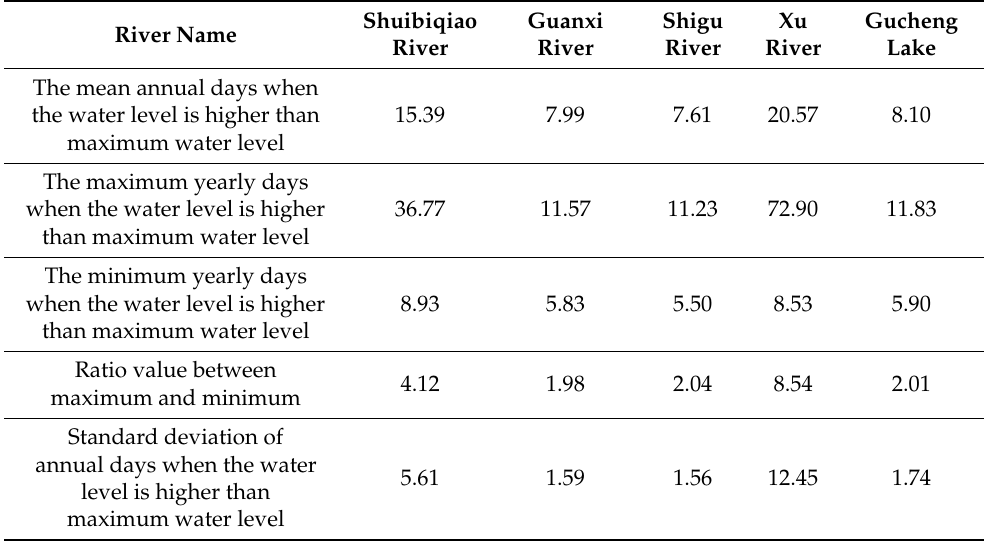
Table 5. The statistical days when the water level is higher than maximum water level under different regulation